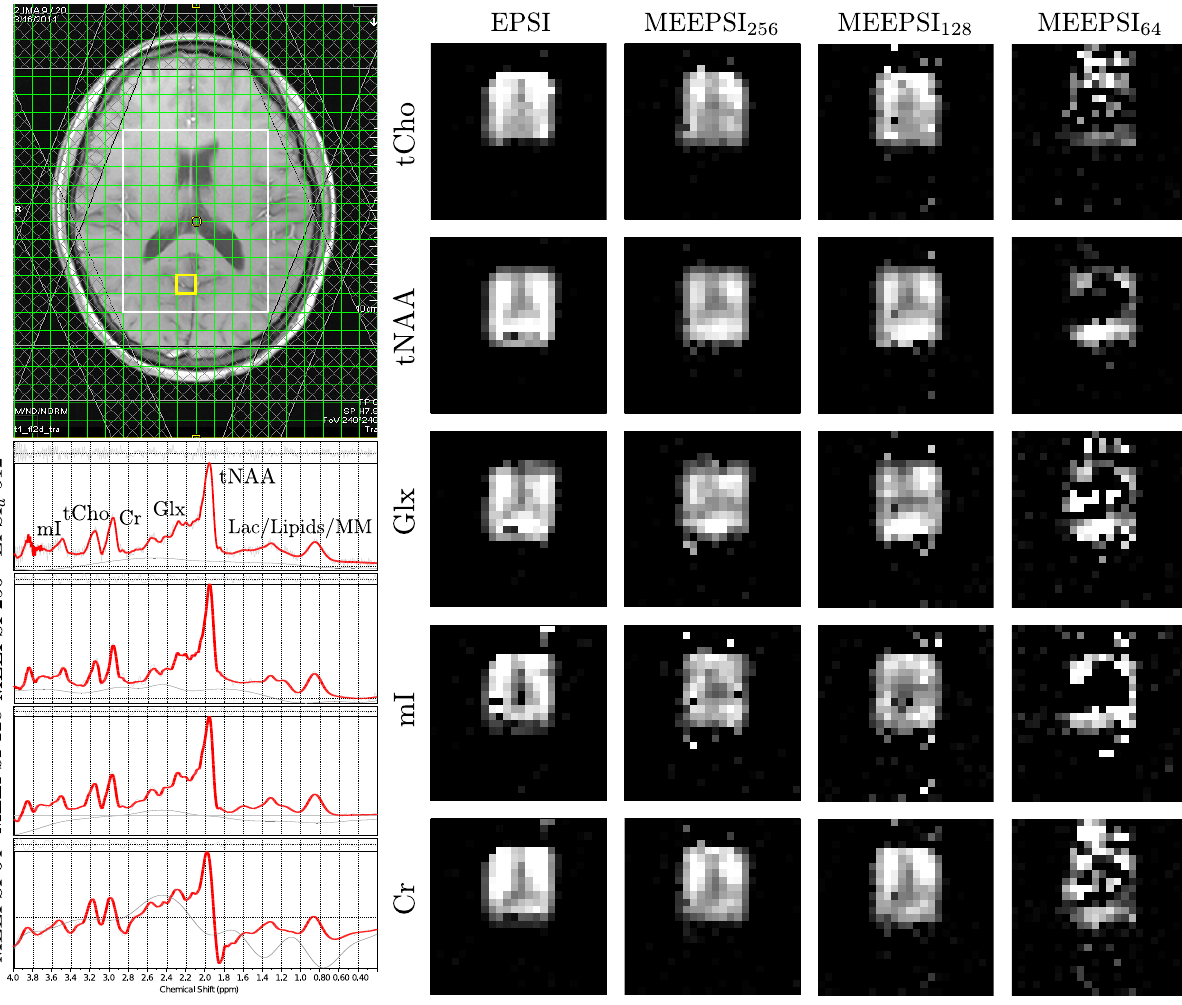
Figure 6. Comparison of fitted LCModel spectra and metabolite maps of a doubly sampled EPSI sequence with different MEEPSI readout lengths. The 2.5 mL spectra are taken from the location marked by the yellow box in the T -localized image. The metabolite maps were 1 constructed from the LCModel fitted values with CRLBs < 30